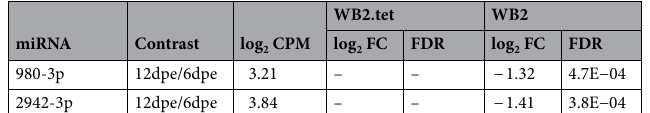
Table 2. Differential expression of 31 miRNAs in older versus younger age groups in each mosquito line. Fold-changes > 0 represent upregulation in the older age group. log 2 CPM, counts per million reads mapped to each miRNA (log 2 ).